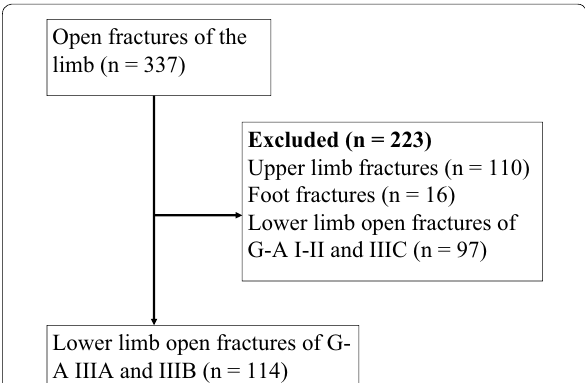
Fig. 1 Flow diagram showing patient identification and